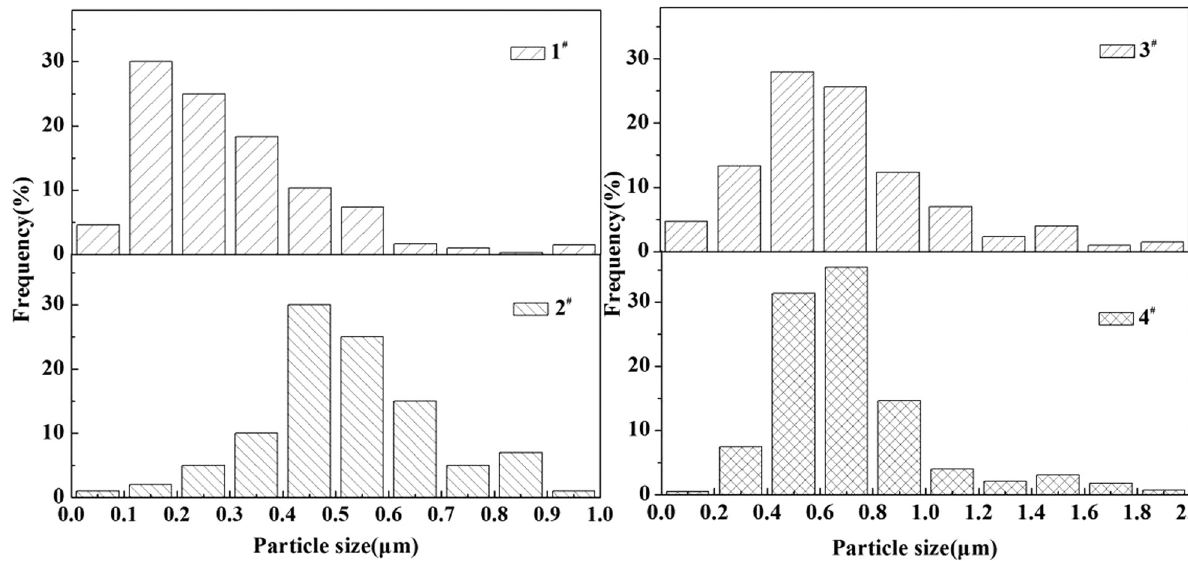
Figure 5: Grain size distribution of Si 4 Al 2 O 2 N 6 ceramics.